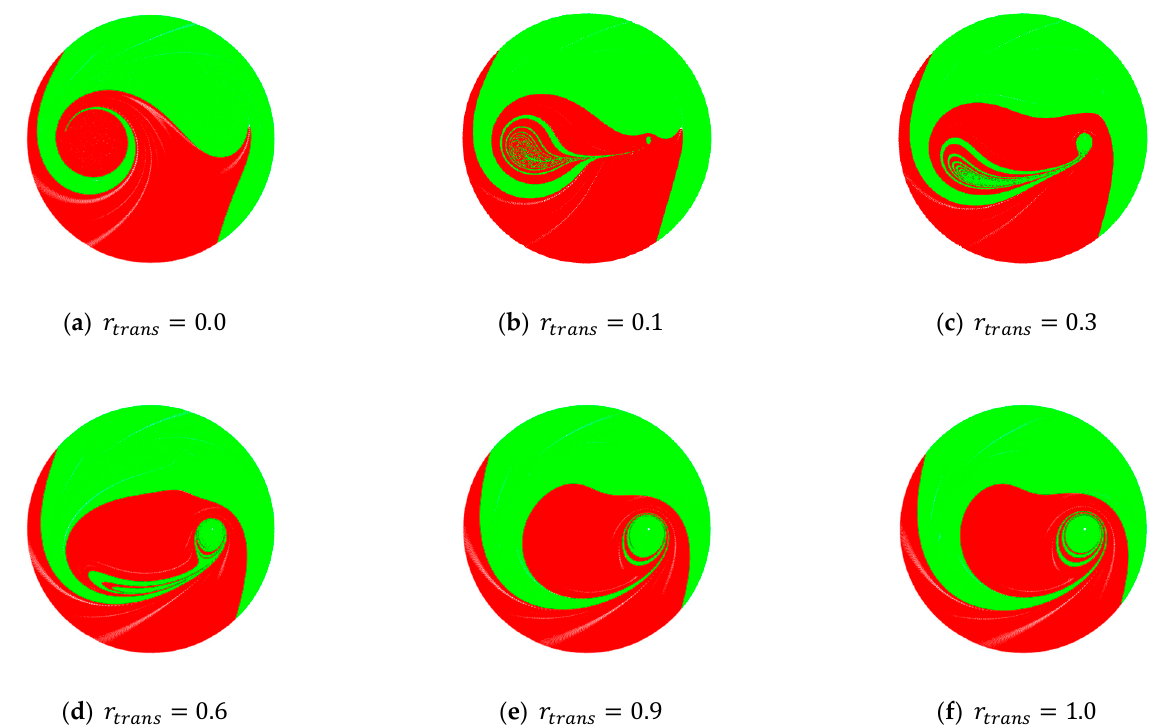
Figure 4. Particle distribution after one iteration with µ of 1 and ν of 0.5 with different transition time.